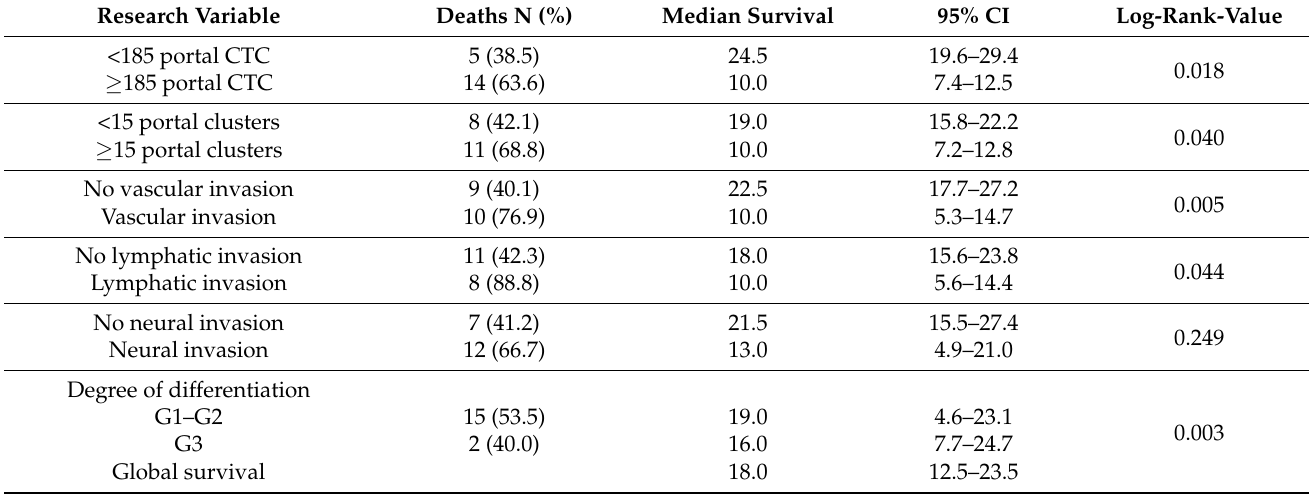
Table 8. Median survival by groups